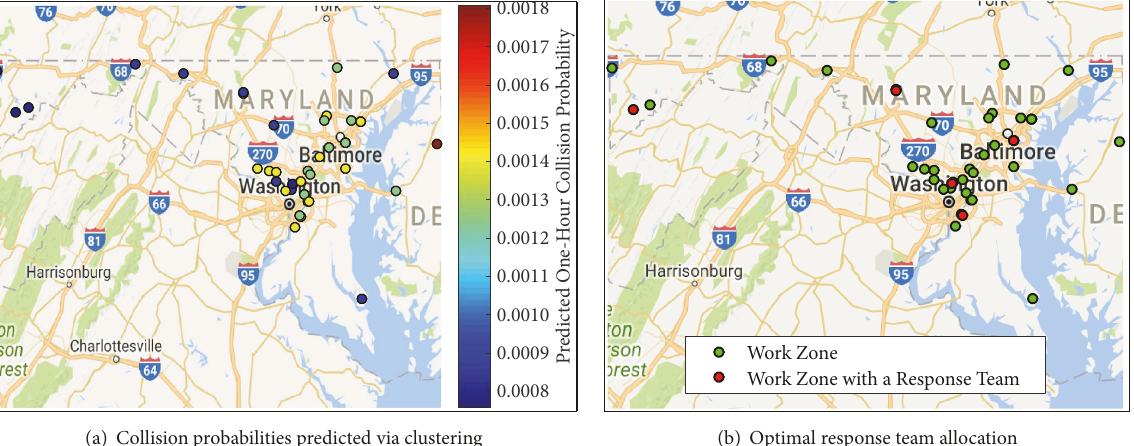
Figure 13: Collision probabilities at 40 future WZs are estimated via the proposed clustering procedure. These probabilities are used as an input for the two-stage stochastic model to optimally allocate 5 highway response